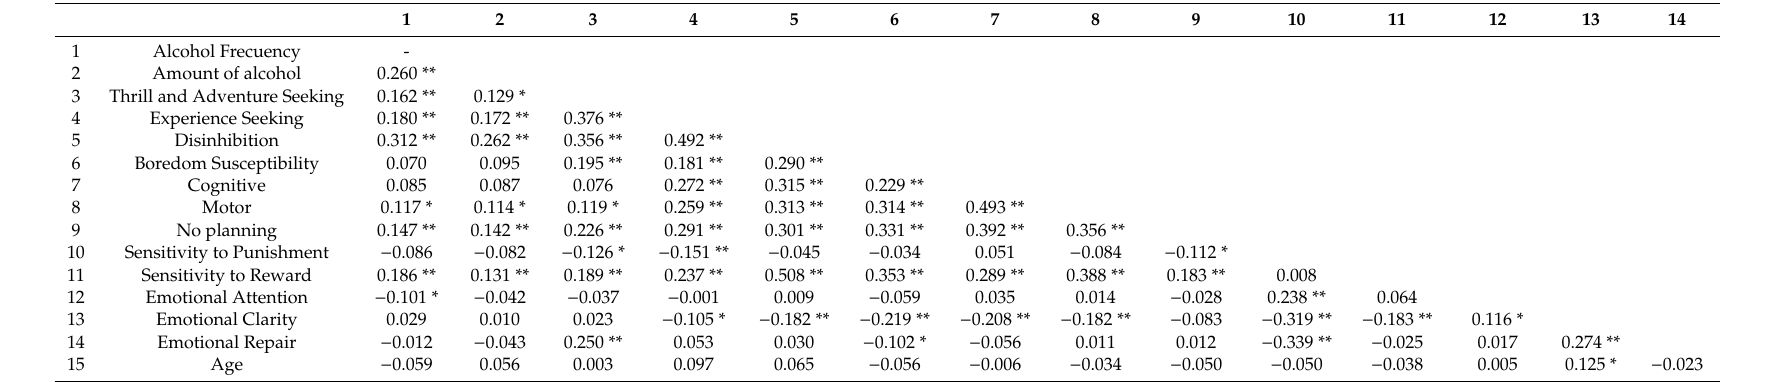
Table 2. Pearson correlations between alcohol, personality trait, emotional intelligence, and age.